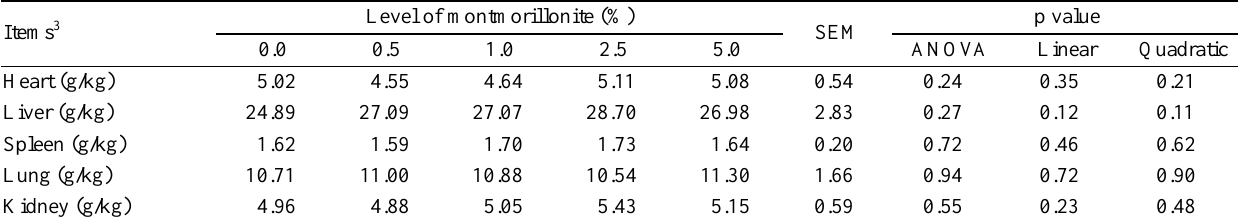
Table 6. Relative organ weight of weaned pigs fed diets containing graded levels of montmorillonite (d 28) 1,2